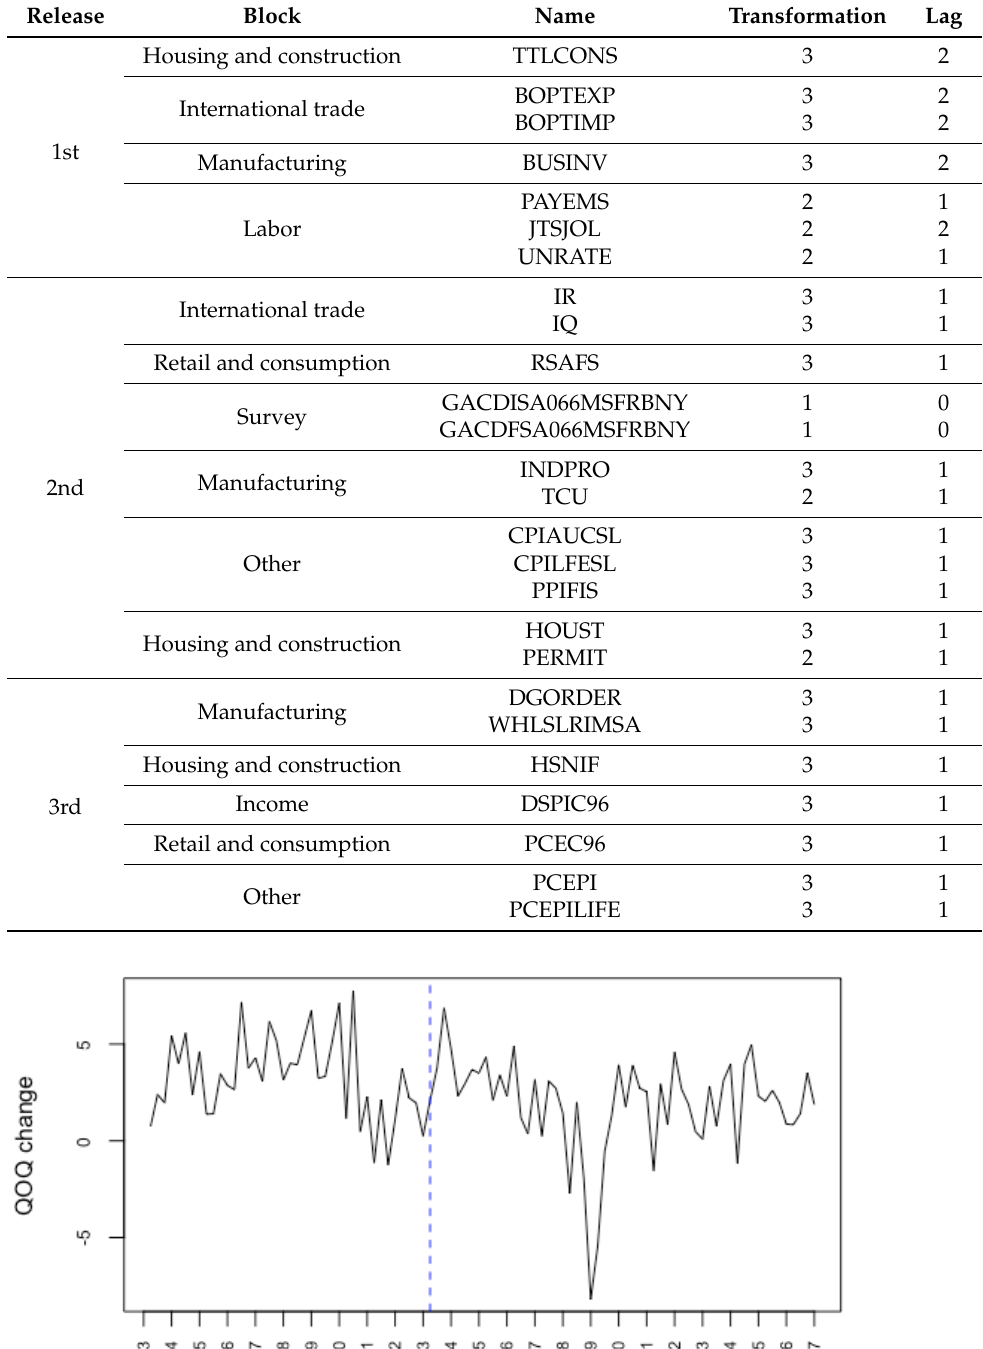
Table 7. Release groups, transformation types, and lag information for monthly series used in the empirical study.